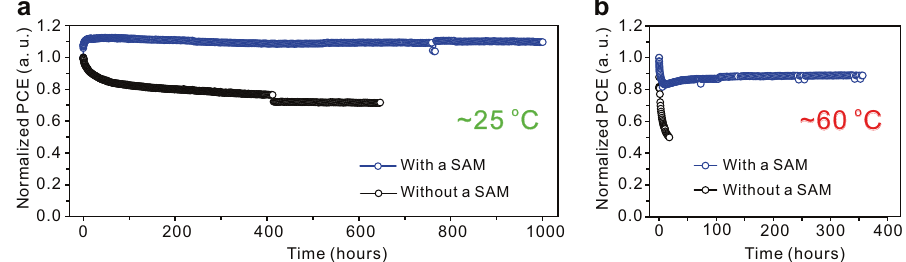
Fig. 4 Addition of a self-assembled monolayer (SAM) improves long-term stability of perovskite solar cells. Ef fi ciency evolution of perovskite solar cells at room temperature (25 °C) ( a ) and at elevated temperature (60 °C) ( b